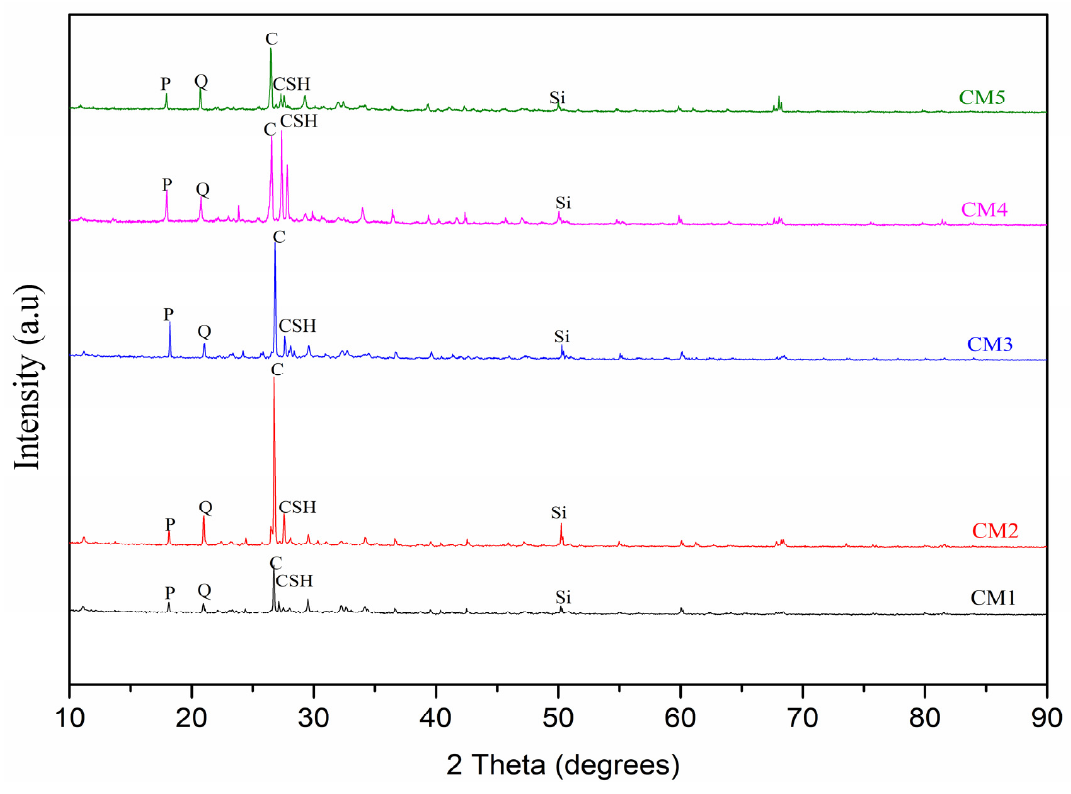
Figure 9. XRD of CM-UFS-GO composites (P—Portlandite, Q—quartz, C—calcite, CSH—calcium silicate hydrate, Si—silicon).